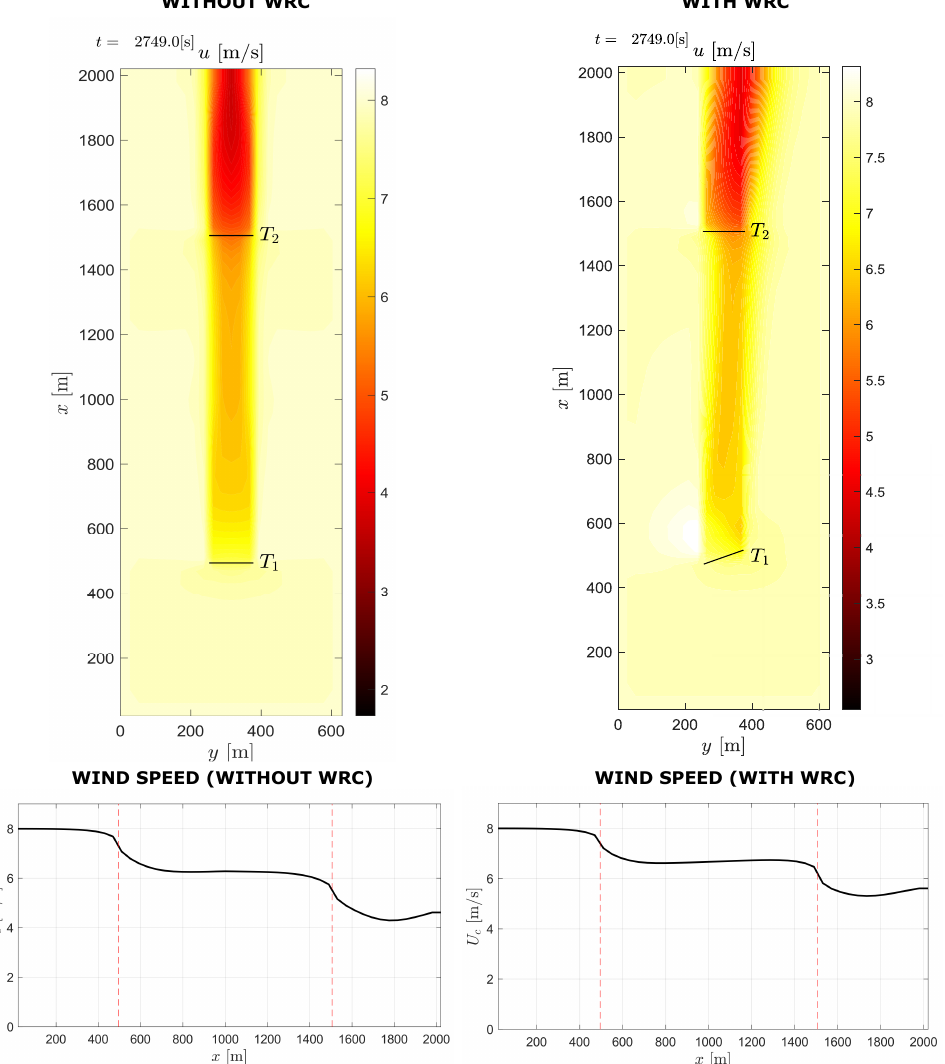
Figure 13. Two-turbine case with and without WRC for 8D